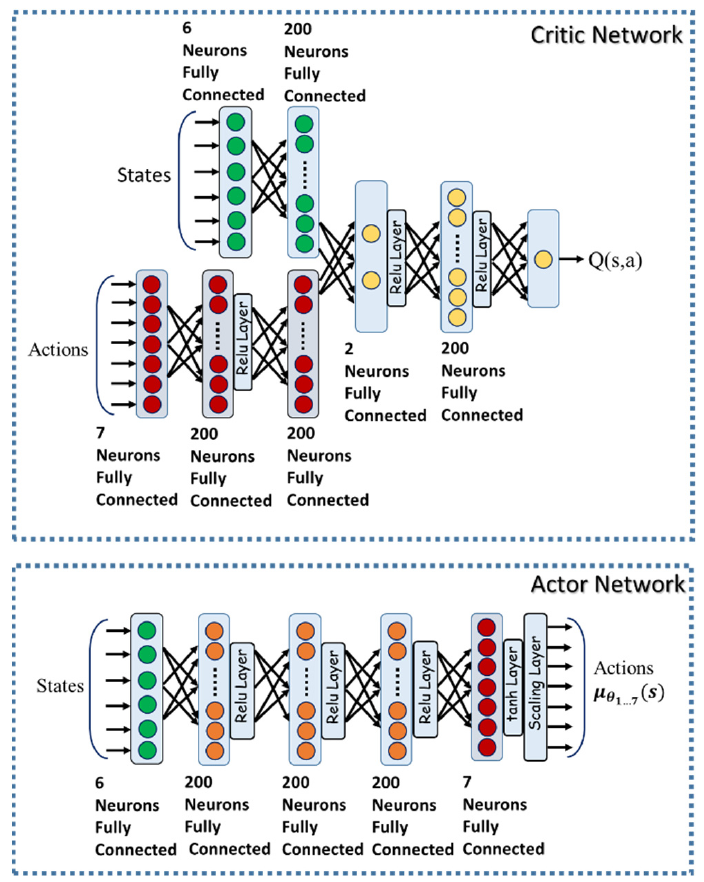
Figure 6. The architecture of actor and critic neural networks.